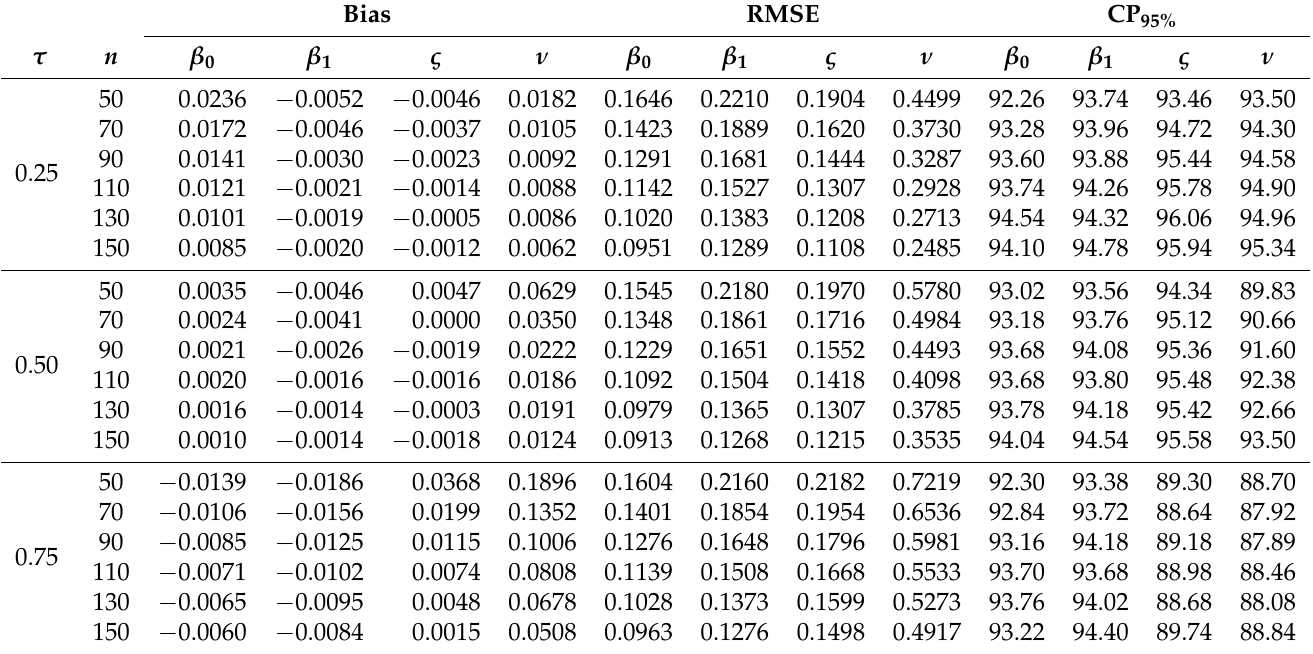
Table 4. Empirical RMSE, bias, and 95% CP (true values: β 0 = 0.50, β 1 = 0.50, ς = 0.50, and ν = 2.00) of the ML estimator for the indicated parameter with simulated